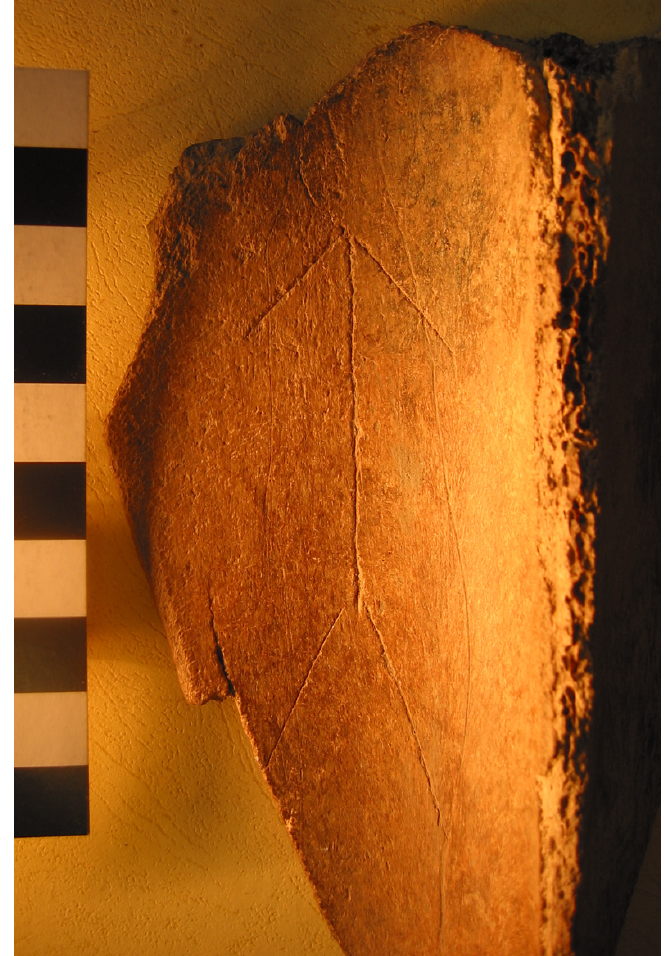
Figure 7. Apparently iconographic engraving on bone, from Oldisleben 1, near Halle, Germany, from a Micoquian context of the last